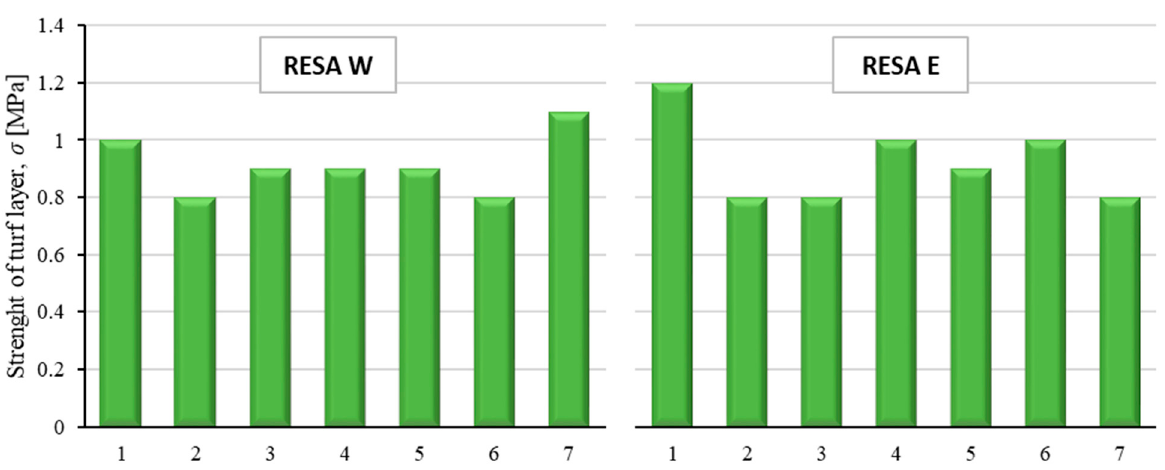
Figure 16. Results of the strength of the turf layer of the airfield pavement on the southern shoulder.